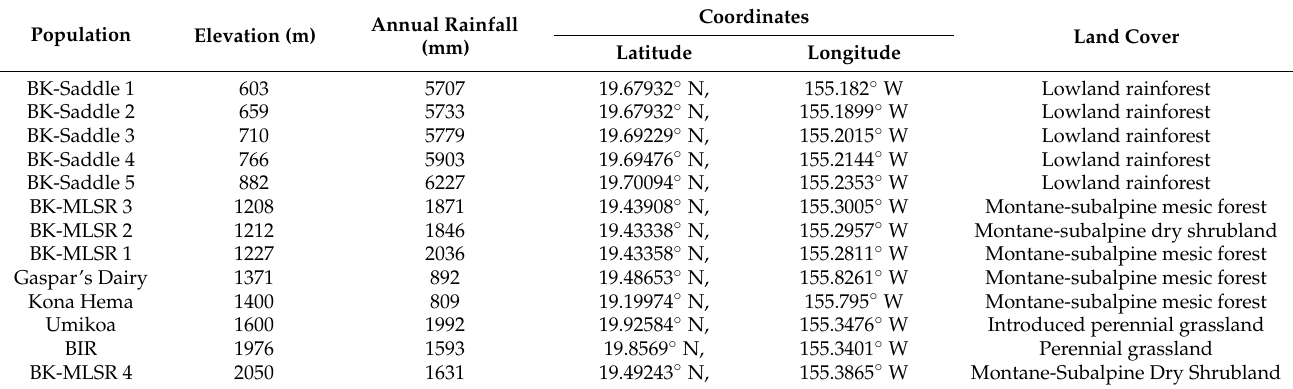
Table 1. Sources, elevation, location, and land cover of the koa populations